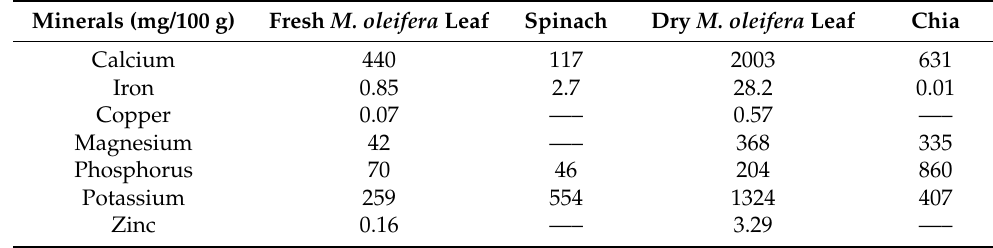
Table 3. Composition of minerals in dried and fresh M. oleifera leaf, spinach, and chia (Sources: [48,58,59]. Minerals (mg/100